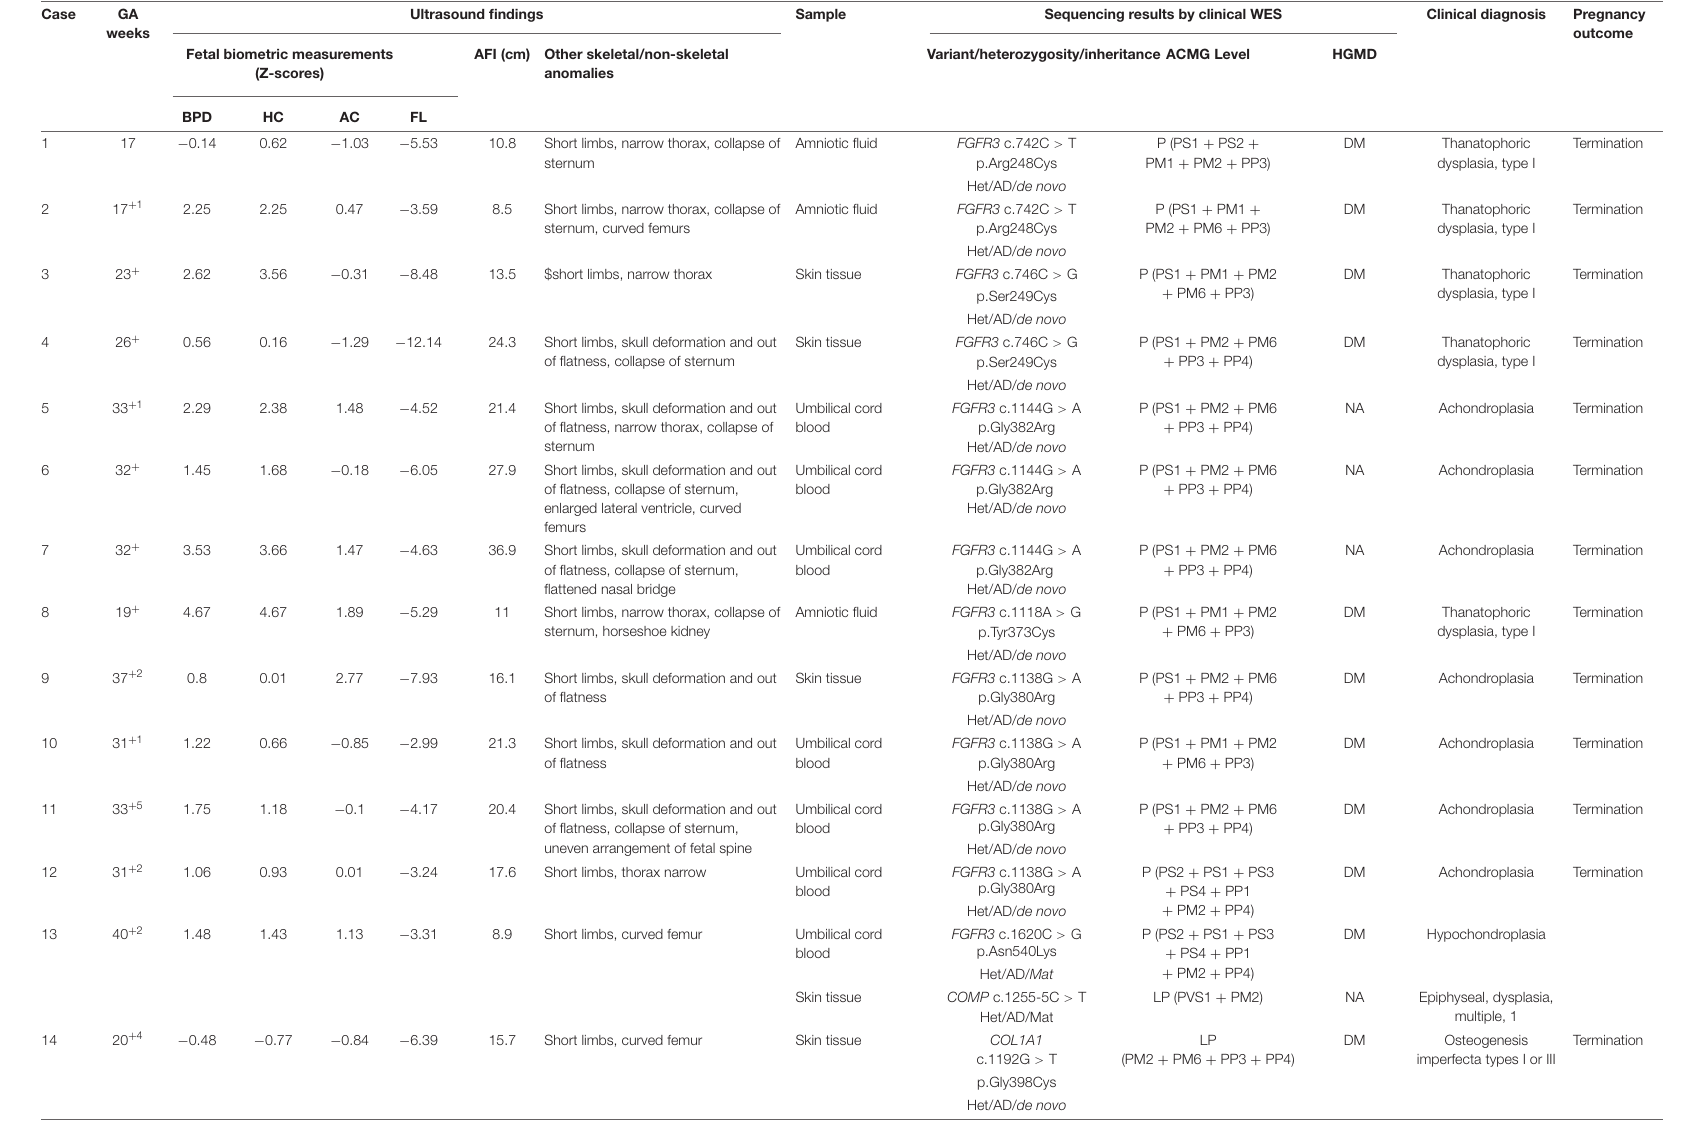
TABLE 1 | Prenatal (ultrasound) phenotype and genotype information for the cohort ( n = 38). Case GA weeks